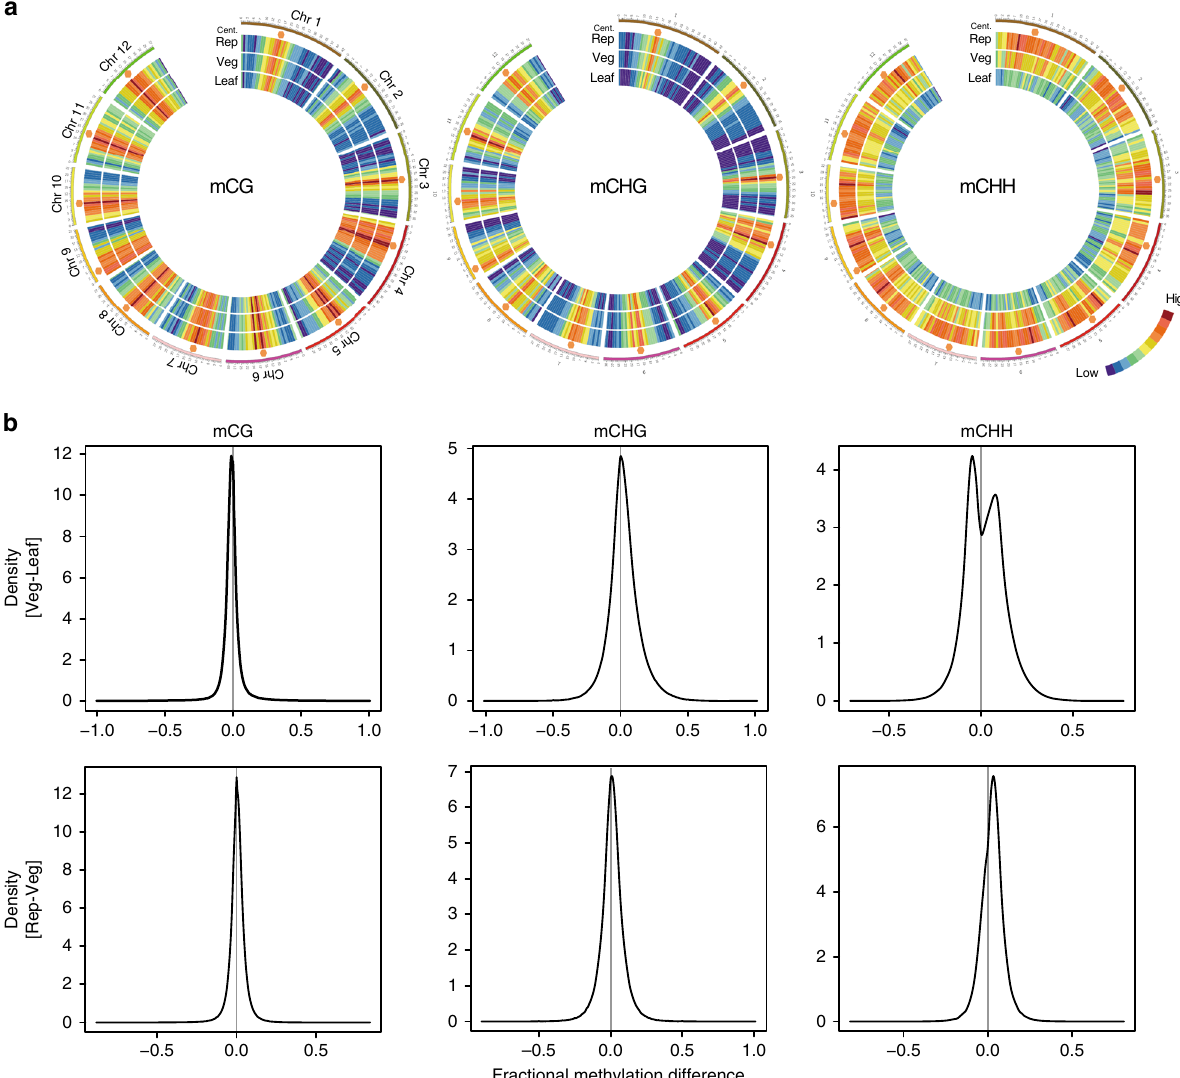
Fig. 1 CHH methylation is kept globally high in the SAM and increases in the reproductive SAM. a Heat maps of the 12 rice chromosomes show cytosine methylation levels in the vegetative SAM (Veg), reproductive SAM (Rep), and mature leaf blade (Leaf) for the CG (left), CHG (middle), and CHH (right) contexts. Average methylation rates were calculated within 1-Mb windows. The maximum for each context was set as the highest cytosine methylation rate among the three organs. Orange hexagons mark pericentromeric regions. b Density plots show the frequency distribution of the methylation differences within 50-bp windows of the whole rice genome between vegetative SAM and mature leaf blade (upper) or between reproductive SAM and vegetative SAM (lower) for CG (left), CHG (middle), and CHH (right). A shift of the peak away from zero represents a global